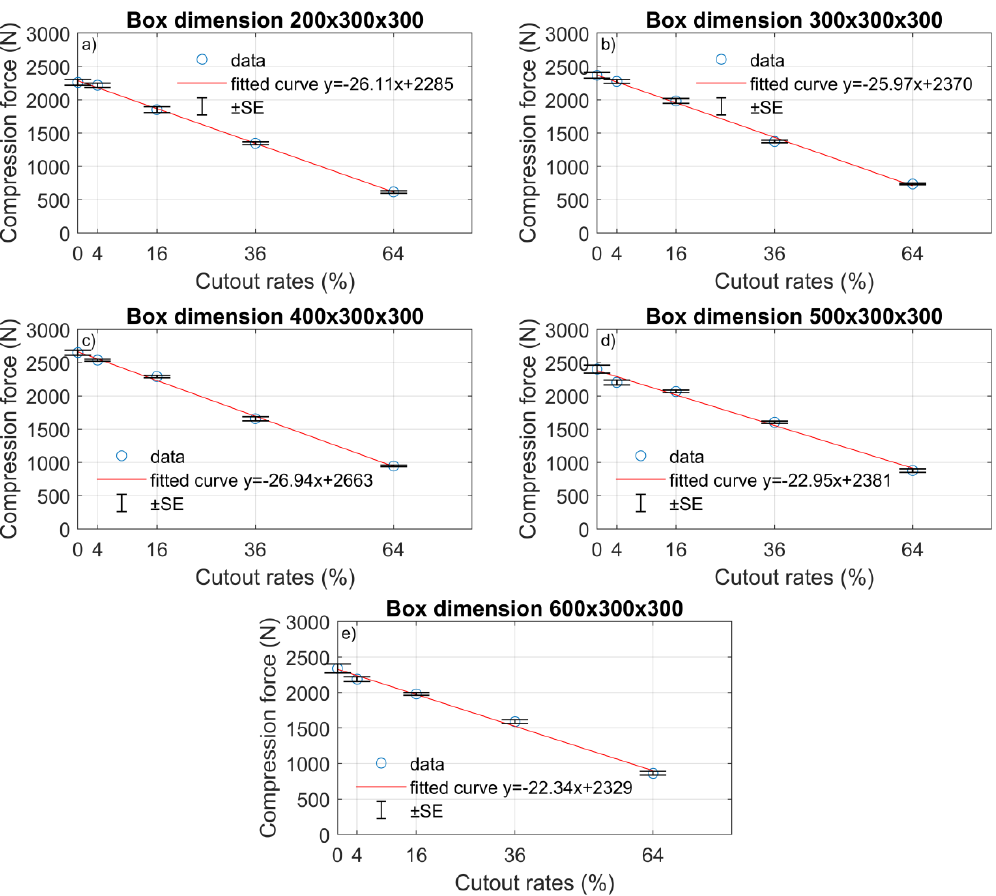
Figure 6. Averages of maximum compression forces and its standard errors (SE): ( a ) 200 × 300 × 300 mm box, ( b ) 300 × 300 × 300 mm box, ( c ) 400 × 300 × 300 mm box ( d ) 500 × 300 × 300 mm box, and ( e ) 600 × 300 × 300 mm box. Table 5. Statistical model of the BCT values for sample boxes. Length (mm)